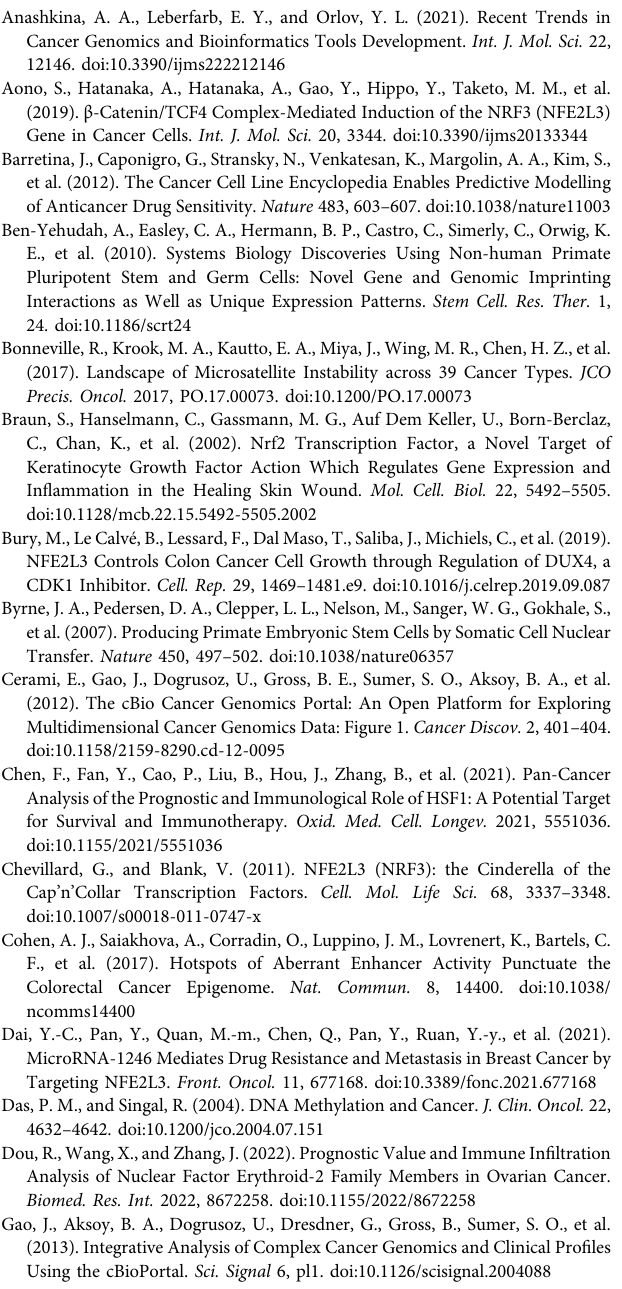
Supplementary Figure S2 | The correlation between NFE2L3 expression and immunomodulators in pan-cancer (A) The correlation between NFE2L3 expression and immunoinhibitors in pan-cancer. (B) The correlation between NFE2L3 expression and immunostimulators in pan-cancer. (C) The correlation between NFE2L3 expression and MHC molecules in pan-cancer. Supplementary Figure S3| Merged plots forGSEA analysisinmultiple tumors. (A) BRCA; (B) CHOL; (C) ESCA; (D) HNSC; (E) KIRC; (F) PRAD; (G) UCEC; (H) THCA. Supplementary Table S1 | Baseline clinical data of TCGA-LIHC